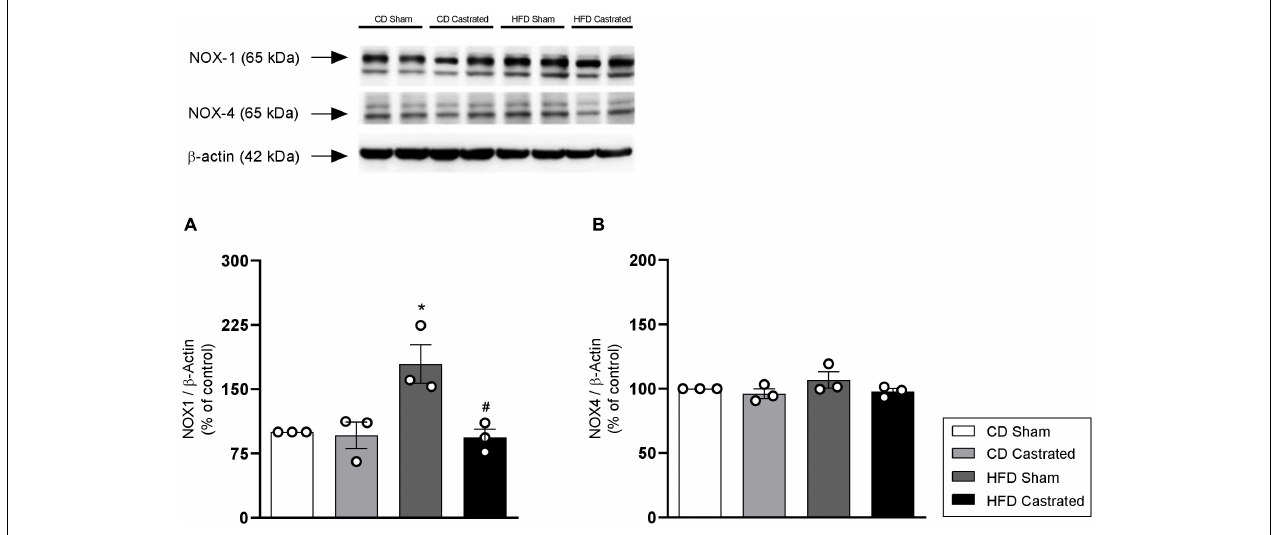
FIGURE 5 | Testosterone contributes to increased vascular NOX1 expression in high fat diet (HFD)-fed mice. The experiments were performed in aortas isolated from mice of the different experimental groups. Total levels of NOX1 (A) and NOX4 (B) , determined by western blot, were normalized by β -actin expression. Data are expressed as mean ± SEM ( n = 3 in all groups). * p < 0.05 vs . CD Sham; # p < 0.05 vs . HFD Sham.